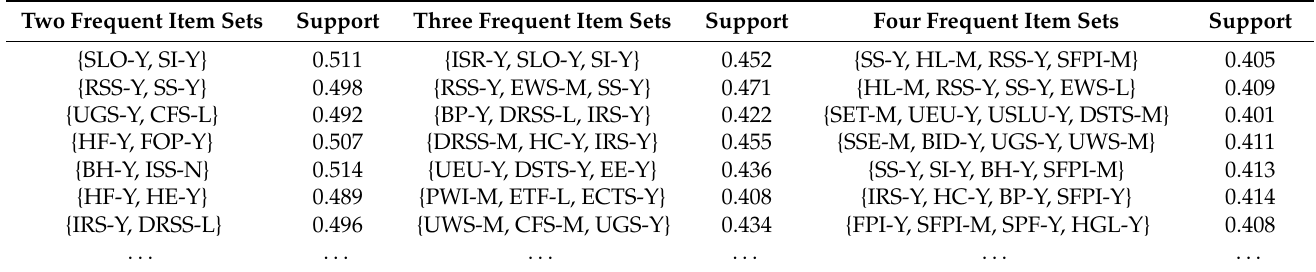
Table 4. Schematic of the association rules.